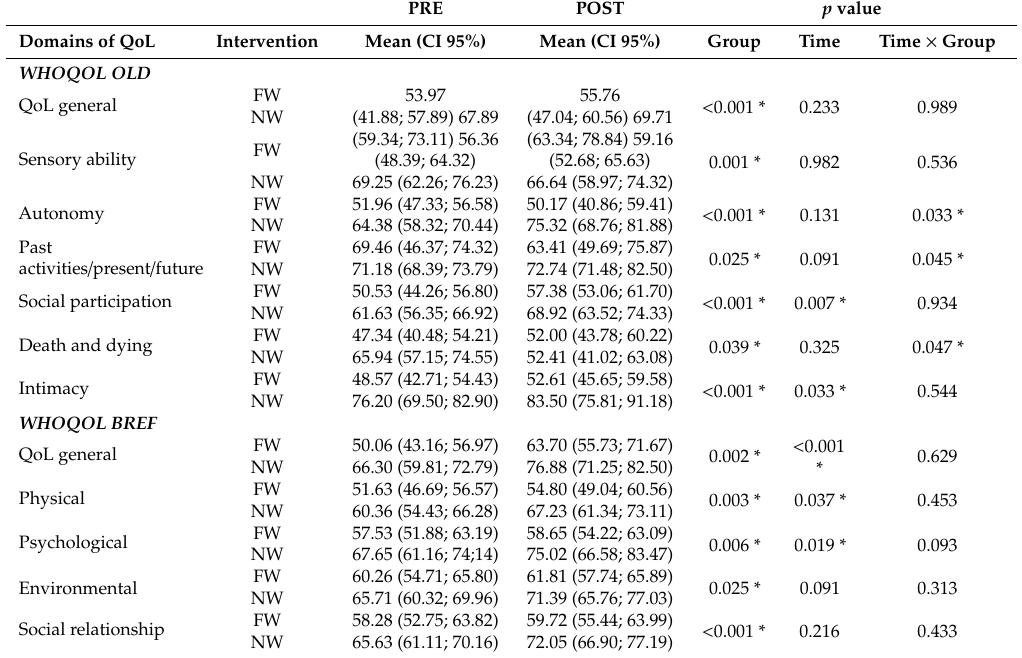
Table 2. Means and 95% confidence interval to WHOQOL OLD and WHOQOL BREF (dependent variables) for Nordic and Free Walking (groups and 2 moments—pre and post—of data collection; independent